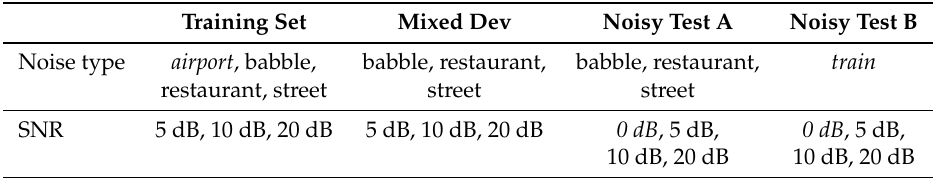
Table 1. Augmented datasets obtained from the WSJ corpus. Conditions, which are different between training and test sets, are highlighted with italic